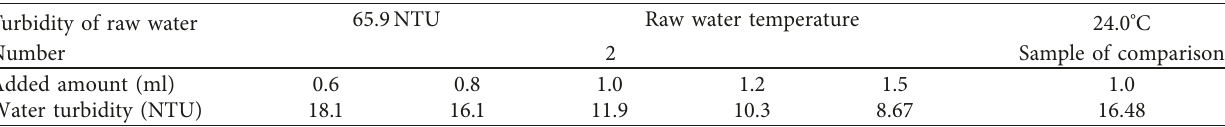
Table 4: Formula no. 2 treatment of tap water source water-related